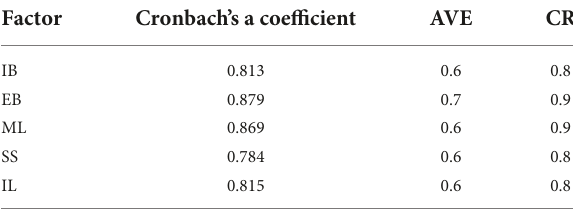
TABLE 3 Reliability statistics for each